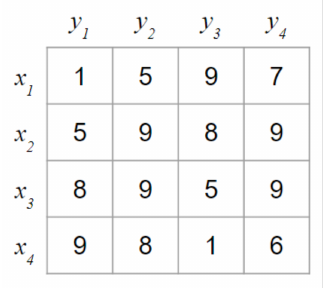
Figure 12. Example used for the numerical